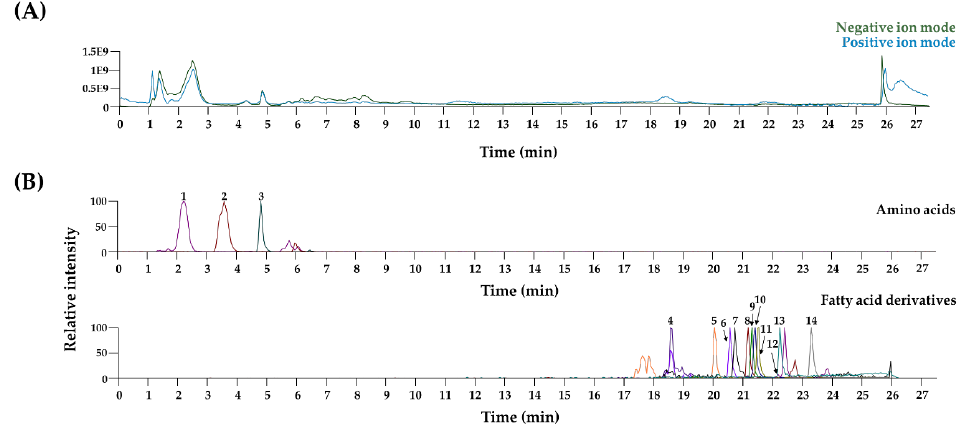
Figure 4. UPLC–tandem MS analysis of LJWE. ( A ) Total ion chromatogram of LJWE. ( B ) Extracted ion chromatograms of LJWE. 1, leucine/isoleucine; 2, phenylalanine; 3, tryptophan; 4, 15-hydroxy-5,8,11,13-eicosatetraenoic acid; 5, stearidonic acid; 6, eicosapentaenoic acid; 7, linolenic acid; 8, hexadecanamide; 9, arachidonic acid; 10, oleamide; 11, linoleic acid; 12, stearamide; 13, palmitic acid; 14, stearic acid.